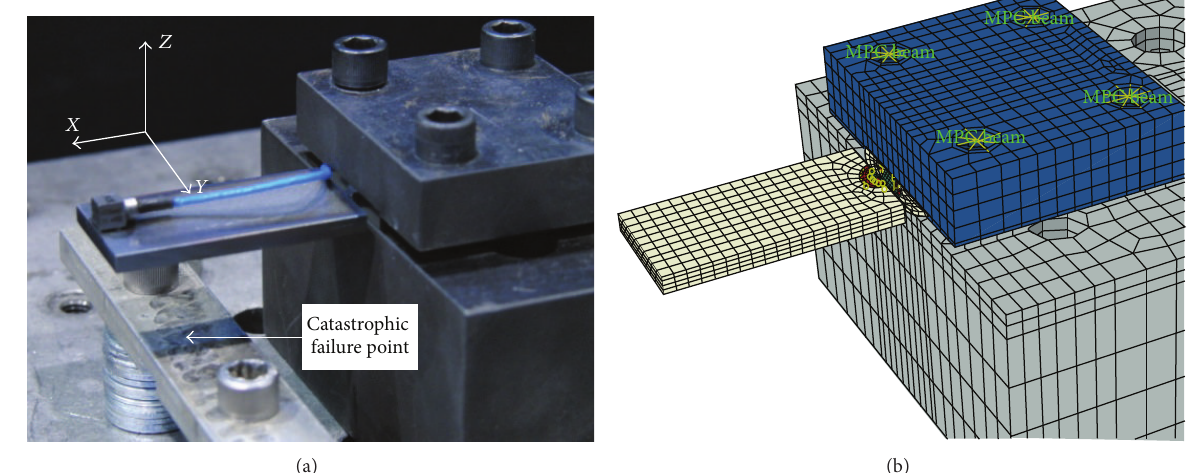
Figure 1: Single-edge cracked cantilever beam experimental and modeling setups.